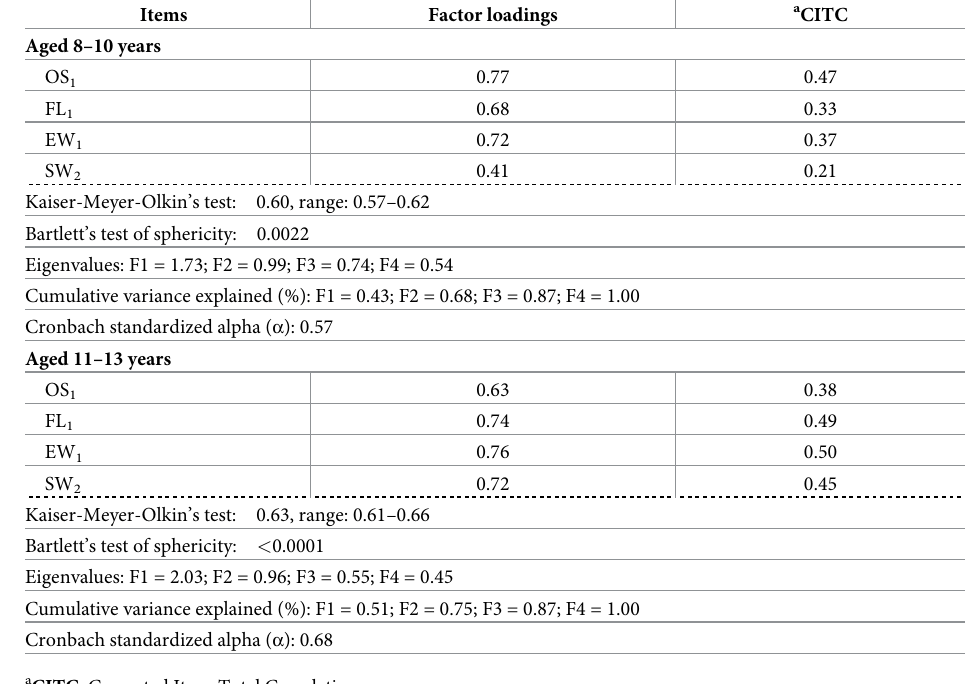
Table 3. 4-item CPQ descriptive, reliability and factor